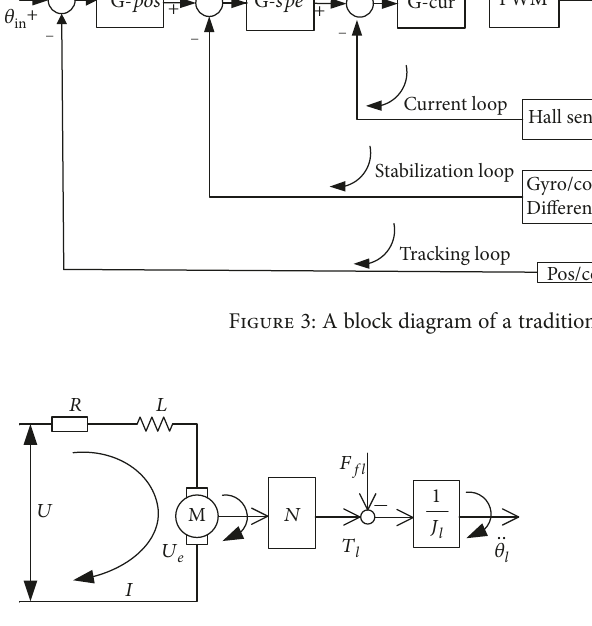
Figure 4: Block diagram for a simpli fi ed gear drive system with fi xed transmission